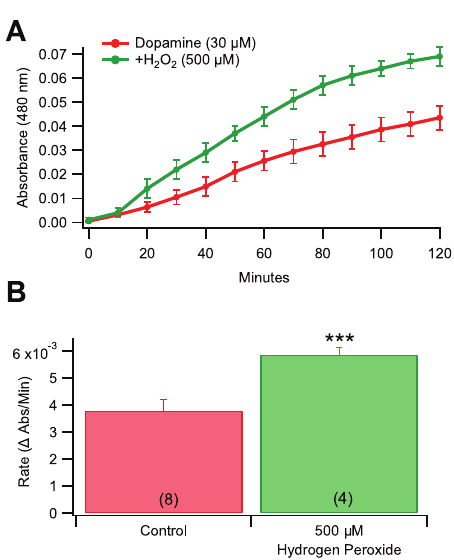
Figure 3. The pro-oxidant H 2 O 2 promotes melanogenesis of DA. ( A ) Hydrogen peroxide (500 µ M) increased DA melanogenesis compared to 30 µ M DA alone. ( B ) Hydrogen peroxide significantly increased the rate of DA melanogenesis. Values in parentheses represent n values. Asterisks *** indicate significance level p < 0.001. Data is presented as mean ± SEM.